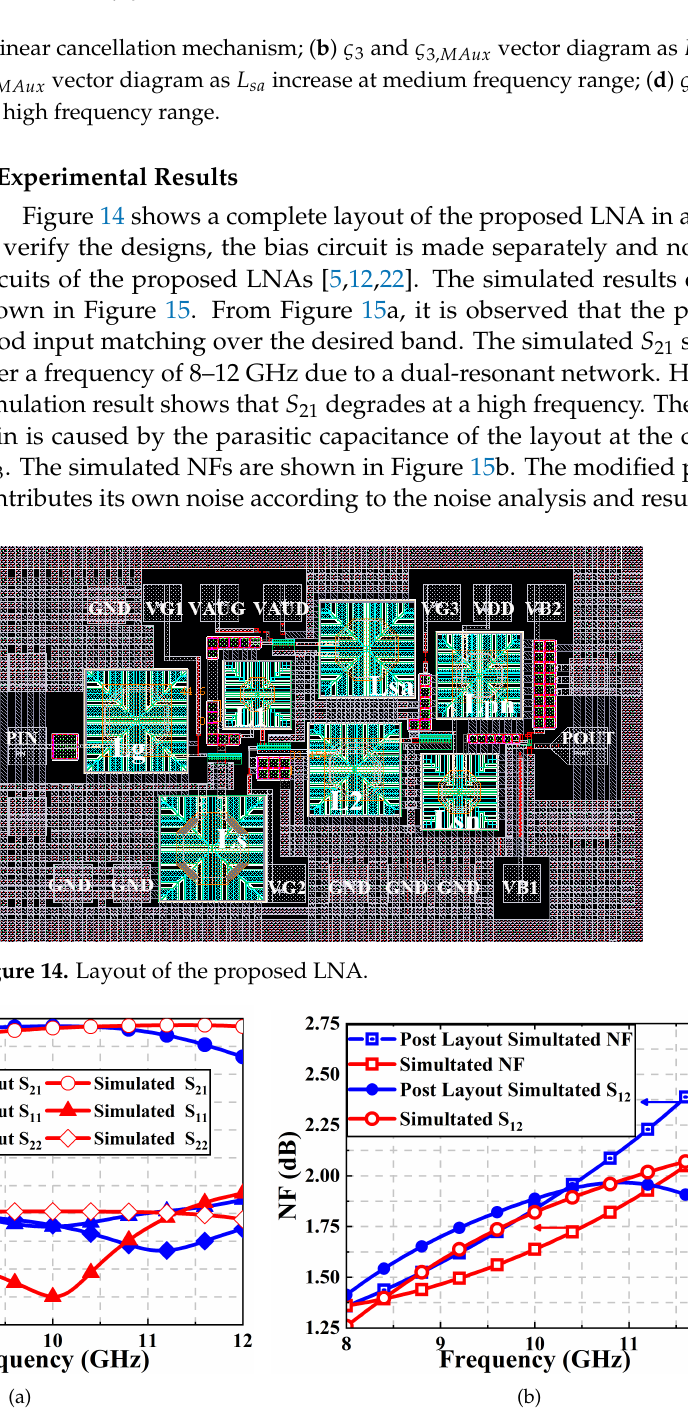
Figure 15. ( a ) Simulated S-parameters of the proposed LNA; ( b ) simulated NF and reverse